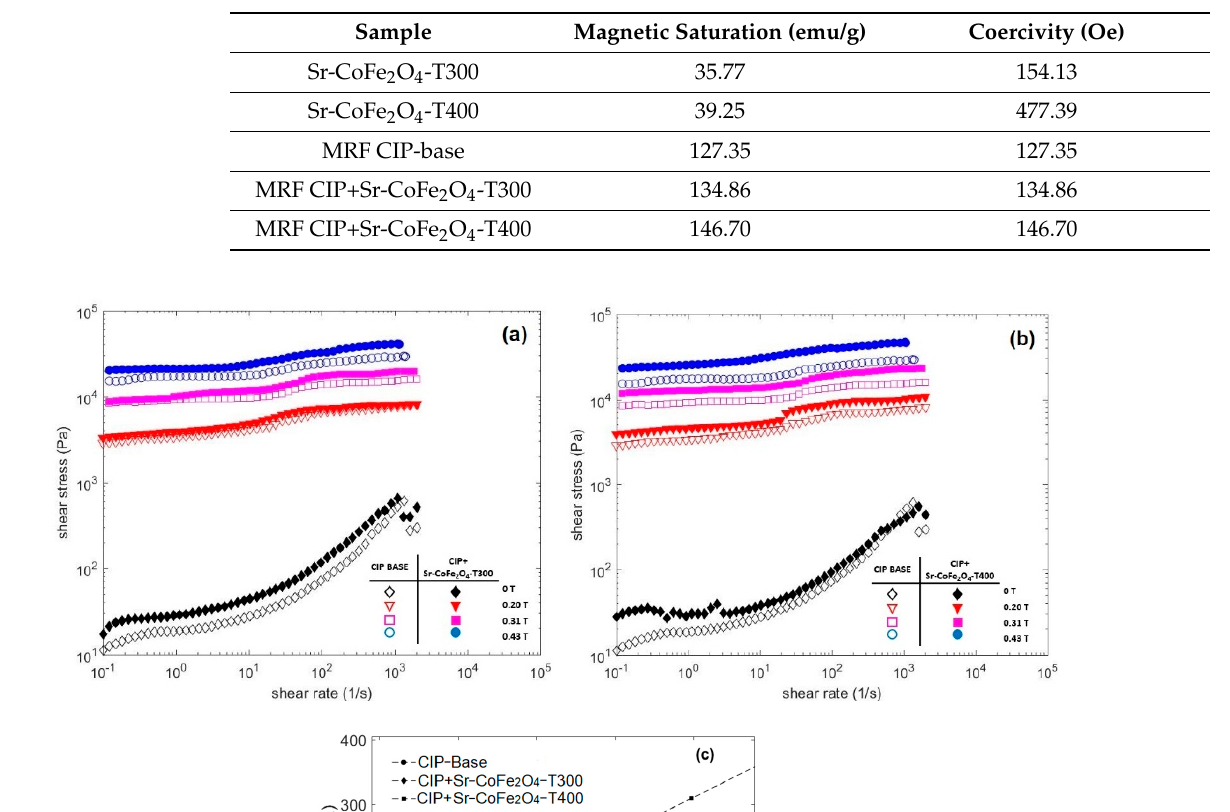
Figure 4. VSM test of ( a ) nanoparticles and ( b ) MRF samples. Table 3. Magnetic properties of nanoparticles and MRF samples.